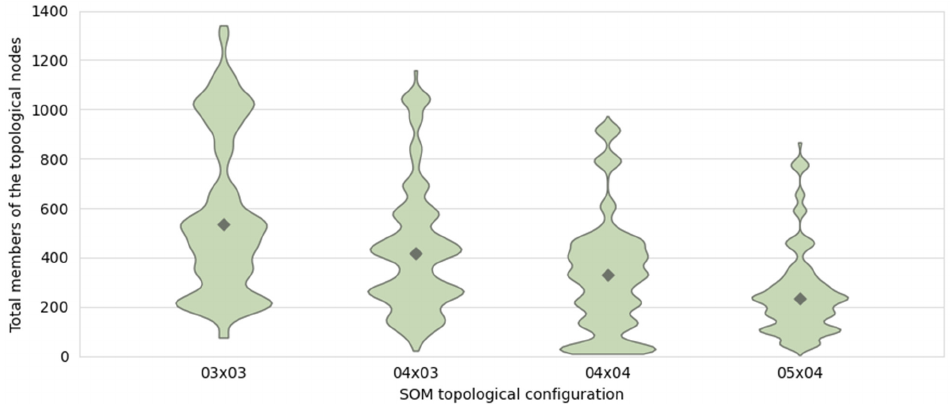
Figure 5. Distribution of the records in the training/validation dataset assigned to different topologi- cal nodes for multiple configurations of SOM dimensions. Diamond markers indicate the median of each distribution.